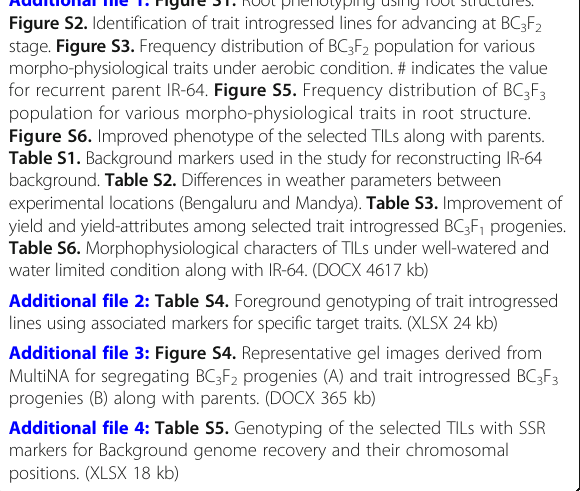
stage. Figure S3. Frequency distribution of BC 3 F 2 population for various morpho-physiological traits under aerobic condition. # indicates the value for recurrent parent IR-64. Figure S5. Frequency distribution of BC 3 F 3 population for various morpho-physiological traits in root structure. Figure S6. Improved phenotype of the selected TILs along with parents. Table S1. Background markers used in the study for reconstructing IR-64 background. Table S2. Differences in weather parameters between experimental locations (Bengaluru and Mandya). Table S3. Improvement of yield and yield-attributes among selected trait introgressed BC 3 F 1 progenies. Table S6. Morphophysiological characters of TILs under well-watered and water limited condition along with IR-64. (DOCX 4617 kb) Additional file 2: Table S4. Foreground genotyping of trait introgressed lines using associated markers for specific target traits. (XLSX 24 kb) Additional file 3: Figure S4. Representative gel images derived from MultiNA for segregating BC 3 F 2 progenies (A) and trait introgressed BC 3 F 3 progenies (B) along with parents. (DOCX 365 kb) Additional file 4: Table S5. Genotyping of the selected TILs with SSR markers for Background genome recovery and their chromosomal positions. (XLSX 18 kb) Abbreviations BGS: Background section; DM/LA: Dry matter per unit leaf area; FC: Field capacity; FGS: Foreground selection; MABC: Marker assisted